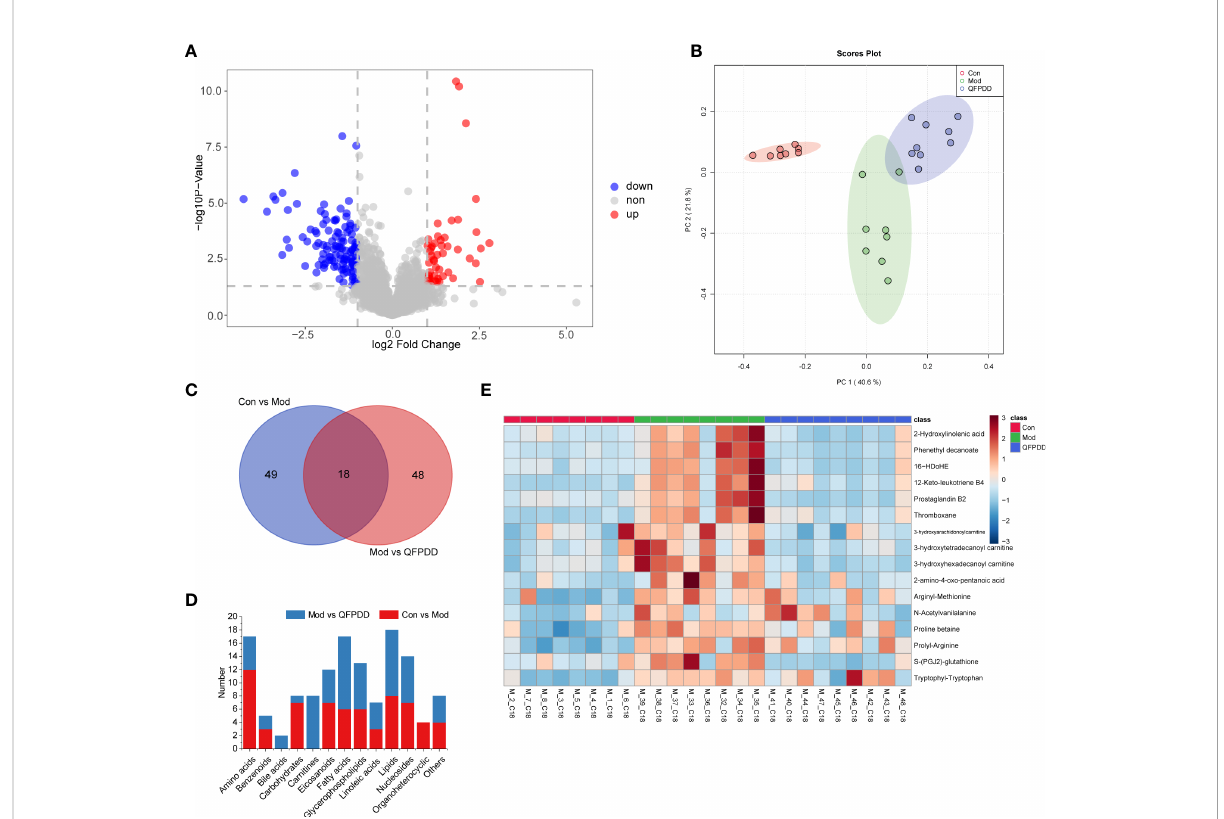
FIGURE 3 Metabolome analysis of lung tissue. (A) Volcano plot showing changes in differential metabolites (DMs) in the Mod and QFPDD groups. (B) The principal component analysis (PCA) plots established based on DMs in the Con, Mod, and QFPDD groups. (C) Venn diagram of DMs in the Con, Mod, and QFPDD groups. (D) The categories and number of DMs obtained from the Con, Mod, and QFPDD groups. (E) Heatmap diagram of DMs in the Con, Mod, and QFPDD